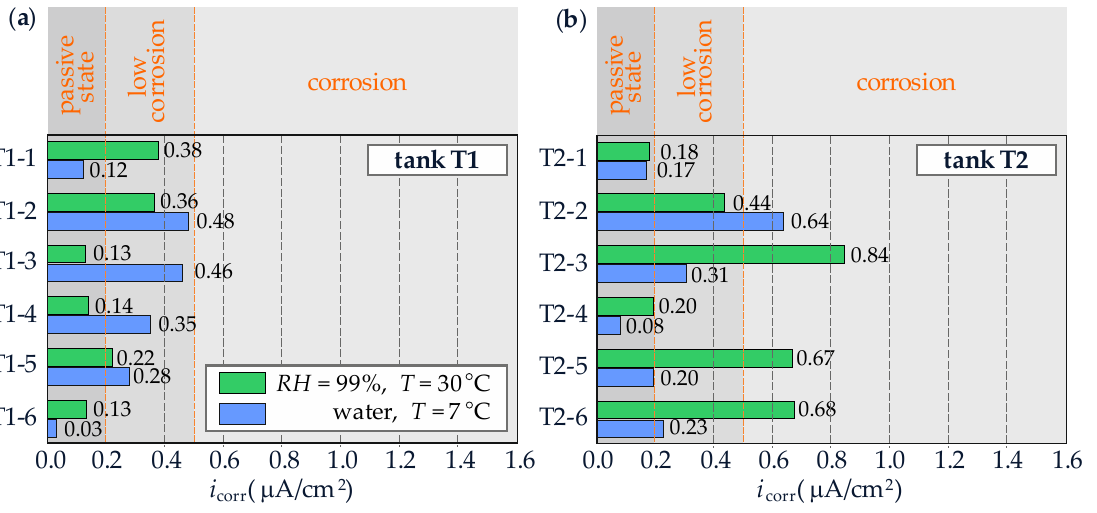
Figure 12. Distribution of corrosion current densities 𝑖 𝑐𝑜𝑟𝑟 presented as horizontal bar graphs, obtained for reinforcement of cylindrical concrete cores drilled from reinforced concrete tanks for fresh water: ( a ) results for the tank T1; and ( b ) results for the tank T2; blue bars represent the tests in water with a temperature 𝑇 = 7 °C; green bars represent the tests at the air temperature 𝑇 = 30 °C and relative humidity 𝑅𝐻 = 99%; information in orange above the graphs show corrosion risk for reinforcement in concrete of the tested cores.